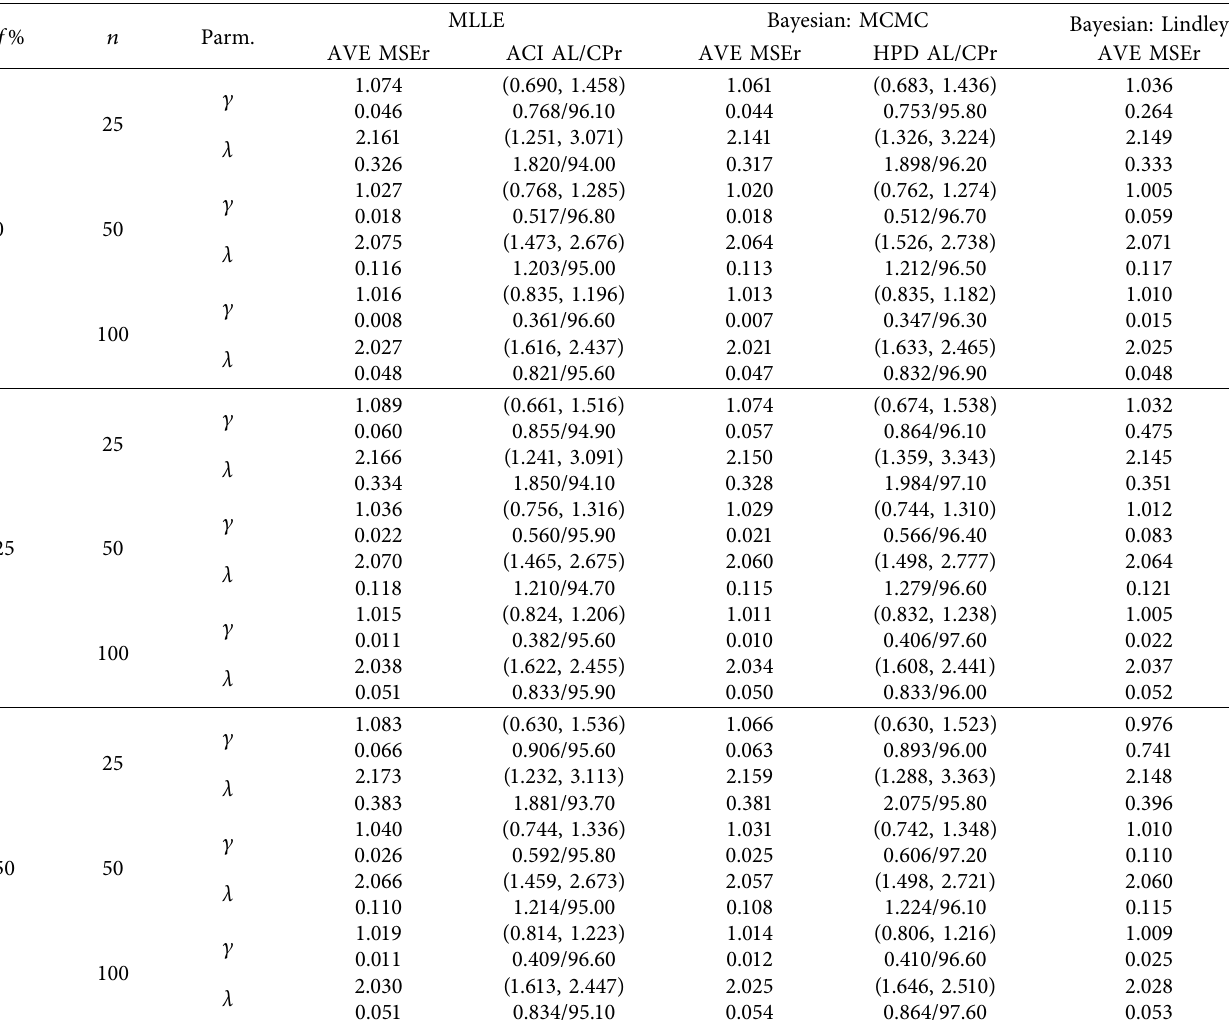
Table 5: Numerical results of AVEs, ACIs, MSErs, ALs, and CPrs (in %) for c � 1 and λ � 2 under number of stages m � 4. MLLE f % n Parm.